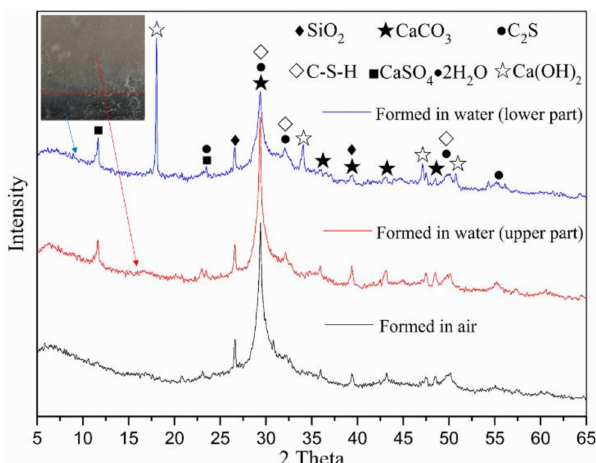
Figure 9. XRD patterns of CSG specimens formed in water and air with the volume ratio of